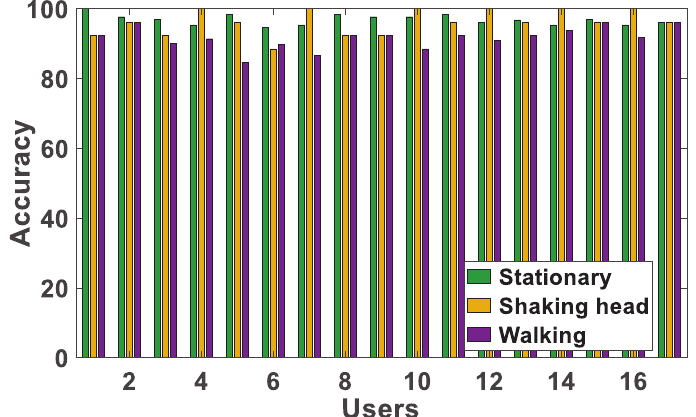
Figure 14. Accuracy of different behaviors.